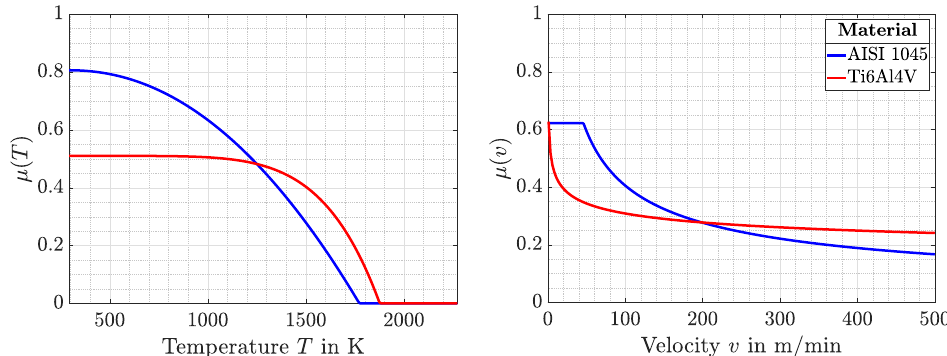
Figure 4. Proposed friction coefficients as a function of: ( Left ) temperature; ( Right ) relative velocity.